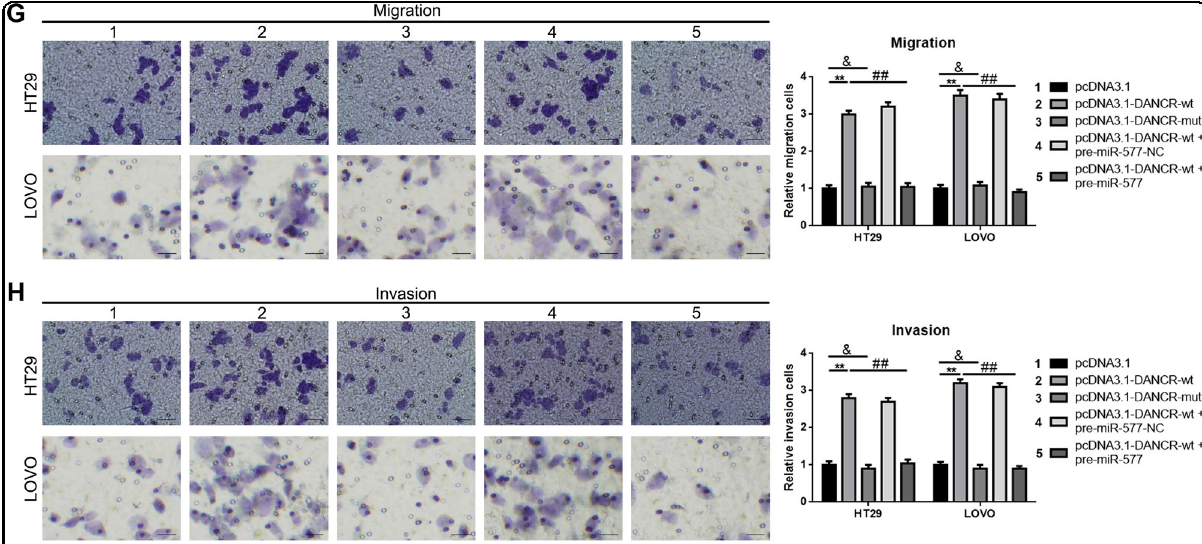
Fig. 6 DANCR promotes proliferation and metastasis via the sponging of miR-577 in CRC cells. a The wild-type DANCR over-expression plasmid pcDNA3.1-DANCR-wt, but not pcDNA3.1-DANCR-mut, could promote HSP27 expression in HT29 and LOVO CRC cells, and the facilitative effect was reversed by pre-miR-577, as detected by qRT-PCR. & P > 0.05, ** P < 0.01 vs. pcDNA3.1 group; ## P < 0.01 vs. pcDNA3.1-DANCR-wt group. b The expression of LRP6 presented the same tendency as HSP27 after the same intervention, as detected by qRT-PCR. & P > 0.05, ** P < 0.01 vs. pcDNA3.1 group; ## P < 0.01 vs. pcDNA3.1-DANCR-wt group. c DANCR negatively regulated miR-577 expression in HT29 and LOVO CRC cells, as detected by qRT-PCR. ** P < 0.01 vs. the NC shRNA group, ## P < 0.01 vs. the pcDNA3.1-DANCR-wt group. d miR-577 also negatively regulated DANCR expression, as detected by qRT-PCR in HT29 and LOVO CRC cells. ** P < 0.01 vs. the pre-miR-577-NC group, ## P < 0.01 vs. the anti-miR-577-NC group. e , f The wild-type DANCR over-expression plasmid pcDNA3.1-DANCR-wt, but not pcDNA3.1-DANCR-mut, promoted HT29 ( e ) and LOVO ( f ) cell proliferation, and the facilitative effect was reversed by pre-miR-577, as determined by the EDU (Scale bar, 25 µm; magni fi cation, ×400) and CCK8 assays. & P > 0.05, ** P < 0.01 vs. the pcDNA3.1 group; ## P < 0.01 vs. the pcDNA3.1-DANCR-wt group. g , h Wild-type DANCR over-expression plasmid pcDNA3.1-DANCR-wt, but not pcDNA3.1-DANCR-mut, promoted HT29 ( g ) and LOVO ( h ) cell metastasis, and the facilitative effect was reversed by pre-miR-577, as determined by Transwell assays. & P > 0.05, ** P < 0.01 vs. the pcDNA3.1 group; ## P < 0.01 vs. the pcDNA3.1-DANCR-wt group (For E-H, Nos. 1 – 5 represent the pcDNA3.1 group, pcDNA3.1-DANCR-wt group, pcDNA3.1-DANCR-mut group, pcDNA3.1-DANCR-wt + pre-miR-577-NC group and pcDNA3.1-DANCR-wt + pre-miR-577 group, respectively). The data are shown as the means ± SD from three independent